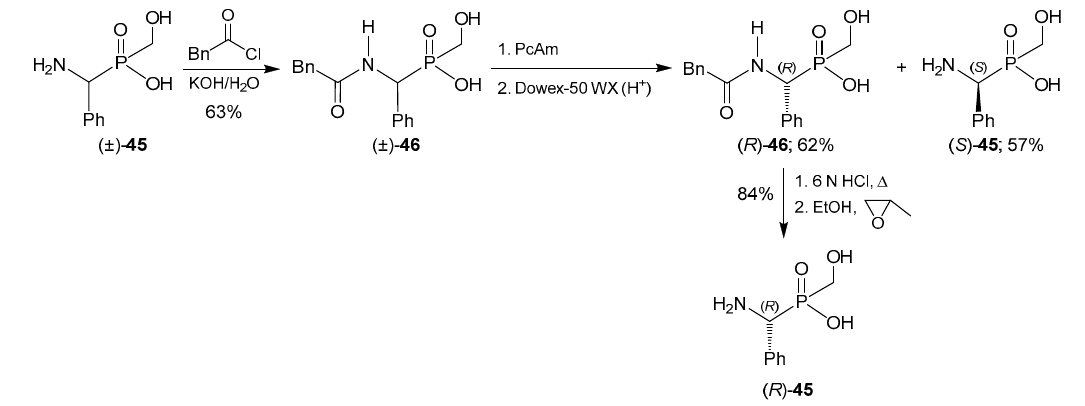
Scheme 23. Chiral HPLC separation of phosphinic dipeptide derivatives 40 and 41 and activities of unprotected derivatives 43 and 44 as inhibitors of leucine aminopeptidase (LAP).